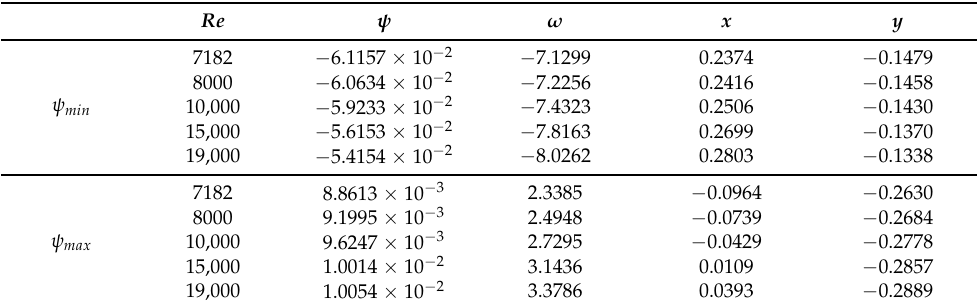
Table 8. Minimum and maximum streamfunction values in the 2nd solution, corresponding vorticity values and ( x , y ) locations for D =